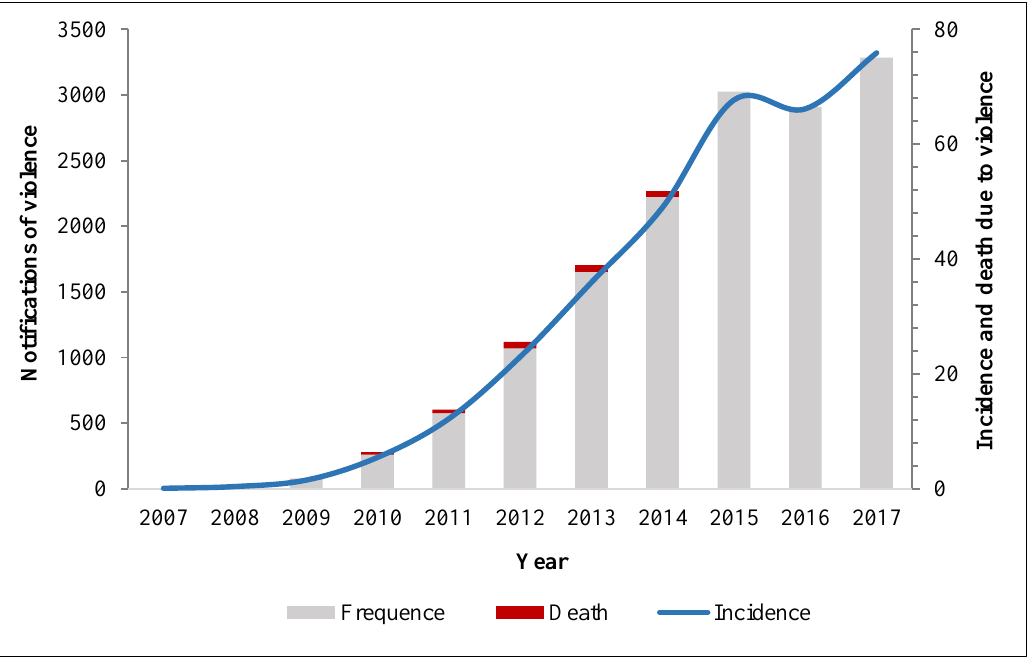
Figure 1. Number of notifications, incidence, and number of deaths, by violence against the elderly, registered in the state of Minas Gerais between 2007 and 2017 Violence against the elderly cases were registered in 814 municipalities of the state of Minas Gerais, ranging from 1 case (minimum) to 1136 cases (maximum) per municipality. On the other hand, deaths secondary to violence against the elderly were registered in 122 municipalities of the state, ranging from one death (minimum) to ten (maximum) deaths per municipality, as shown by Figure 2.